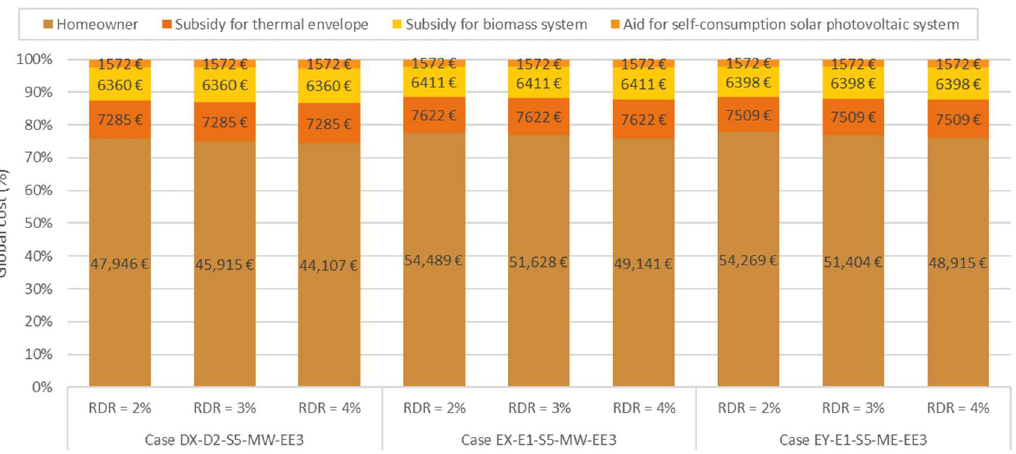
Figure 11. Global cost, in EUR and %, at the different real discount rates for the optimal energy renovation solution in each CCZ, broken down by subsidies and aid to be received by the homeowner and global cost the homeowner is responsible for.